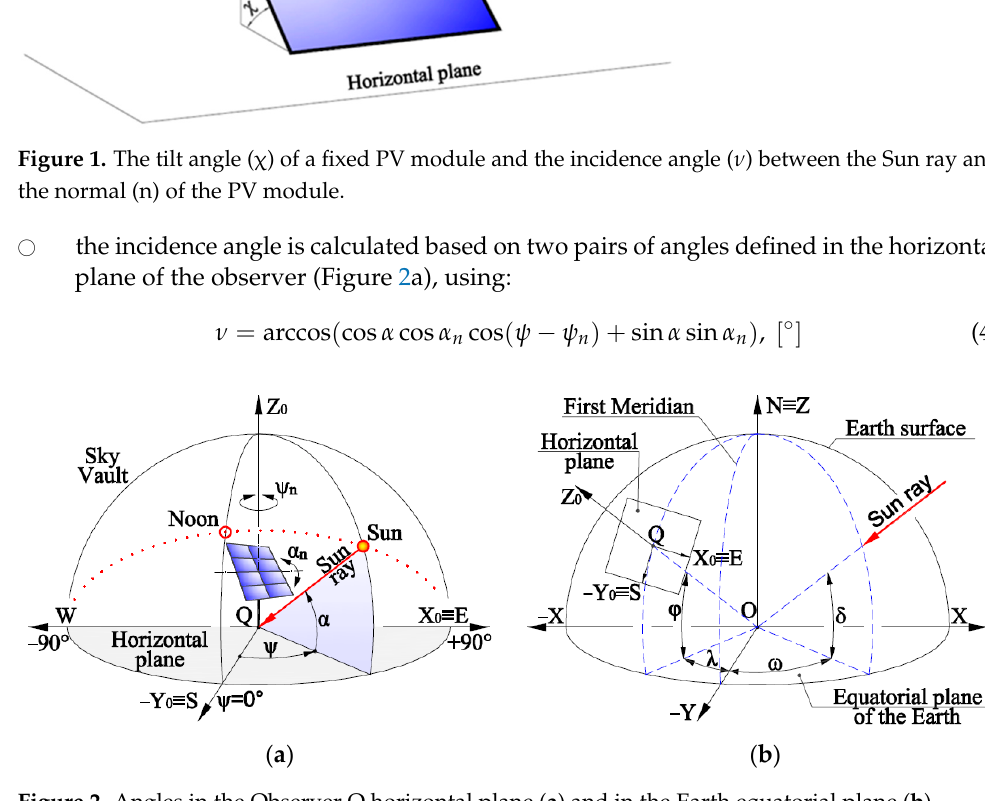
Figure 2. Angles in the Observer Q horizontal plane ( a ) and in the Earth equatorial plane ( b ).